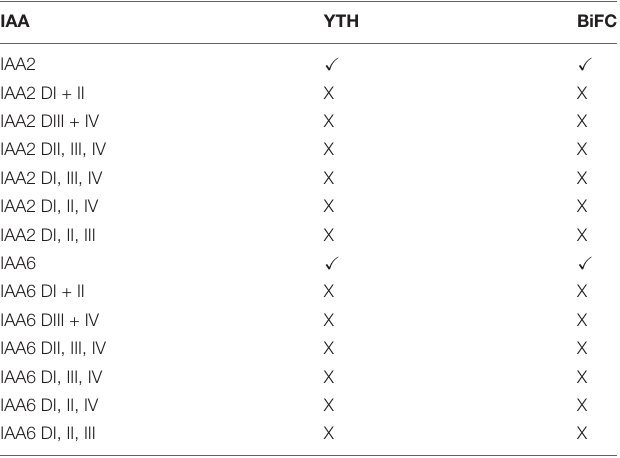
TABLE 2 | Results of the YTH and BiFC assays with the different domain variants of IAA2 and IAA6 with p25 wt.